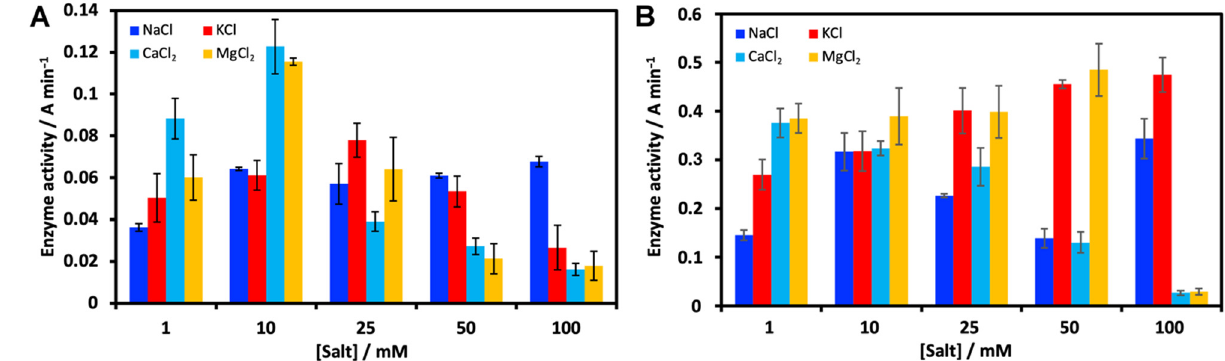
Figure 2. Effect of salt concentration on ( A ) Slt35 and ( B ) lysozyme activity. For Slt35, 7 μ M enzyme and 0.6 mg ml − 1 cell suspension were used at 37 °C in 25 mM Tris-maleate (pH 5.8). For lysozyme, 0.1 μ M enzyme and 0.6 mg ml − 1 cell suspension were used at 37 °C in 25 mM Tris-maleate (pH 6.0).